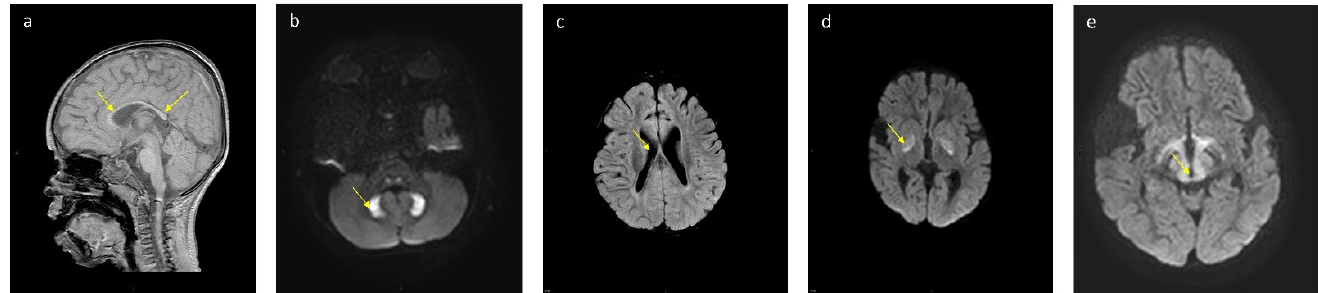
Figure 1. Representative Brain MRIs: ( a ) partial agenesis of corpus callosum. ( b ) DWI restriction of dentate nucleus. ( c ) moderate ventriculomegaly. ( d ) 2-DWI restriction of globus pallidum. ( e ) 2-DWI restriction of midbrain.